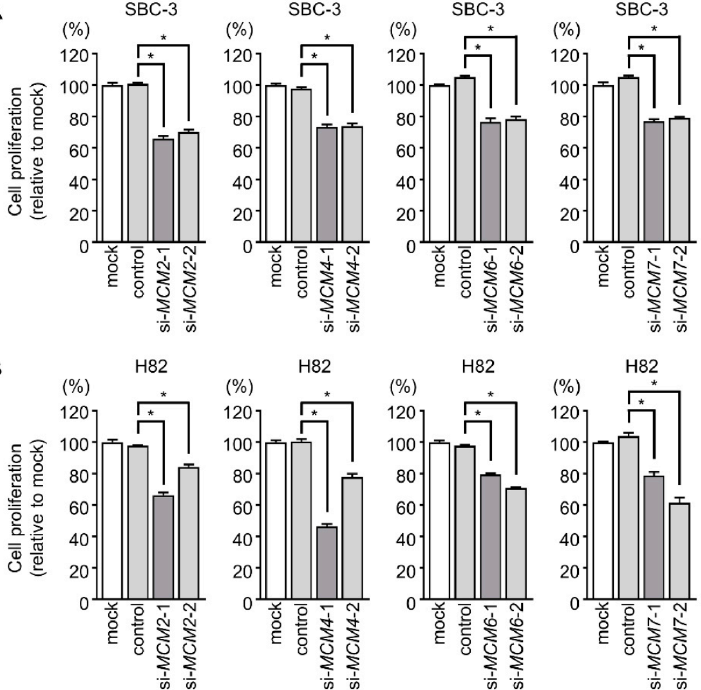
Figure 4. Effect of siRNA-mediated knockdown of MCM family members on the proliferation of SCLC cells. ( A , B ) Cell proliferation was evaluated by XTT assay. Cell proliferation was suppressed by transfection of siRNAs targeting MCM2 , MCM4 , MCM6 , or MCM7 in SBC-3 and H82 cells. *, p <